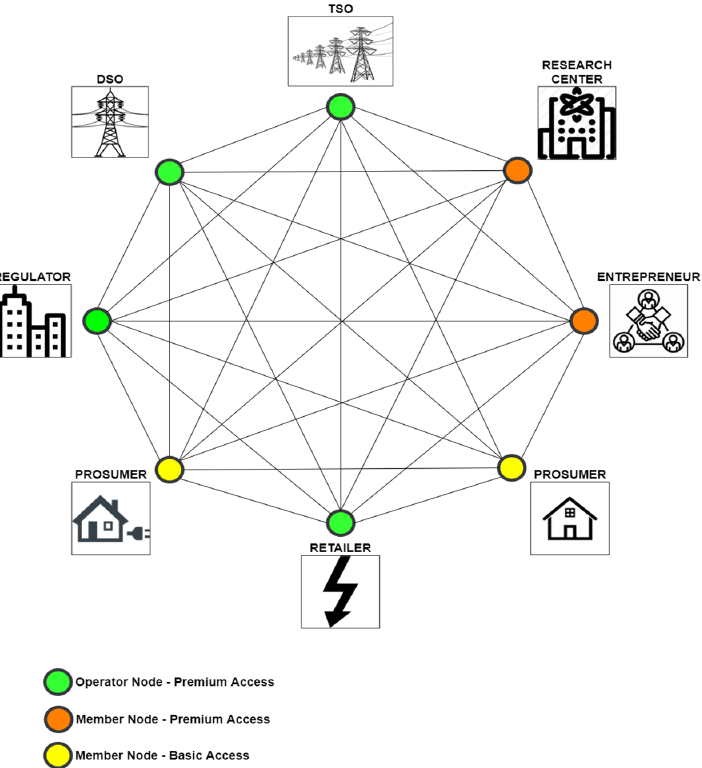
Figure 1. Blockchain-based Energy Datahub (DenHub) Ecosystem Participants.